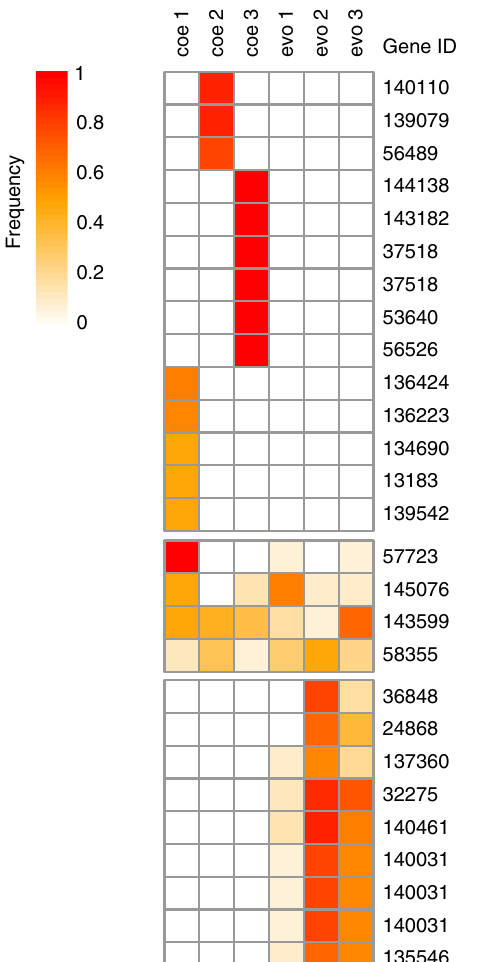
Fig. 5 Frequency of non-synonymous high frequency variants distributed across 24 genes. Frequencies of non-synonymous and high frequency variants and their corresponding frequency in all populations. Each row is annotated with the gene ID that is affected by a particular variant. Four genes had variants both in evolved and coevolved populations. If genes had variants in one of the evolved populations, they were always found in at least another evolved population, and one gene (140031) had mutations at three positions at high frequency. In contrast, variants identi fi ed in the coevolved populations were speci fi c to only one population, and one gene (37518) had mutations at two positions at high frequency. Abbreviations coe1 – coe3 correspond to the three coevolved populations. Abbreviations evo1 – evo3 correspond to the three evolved